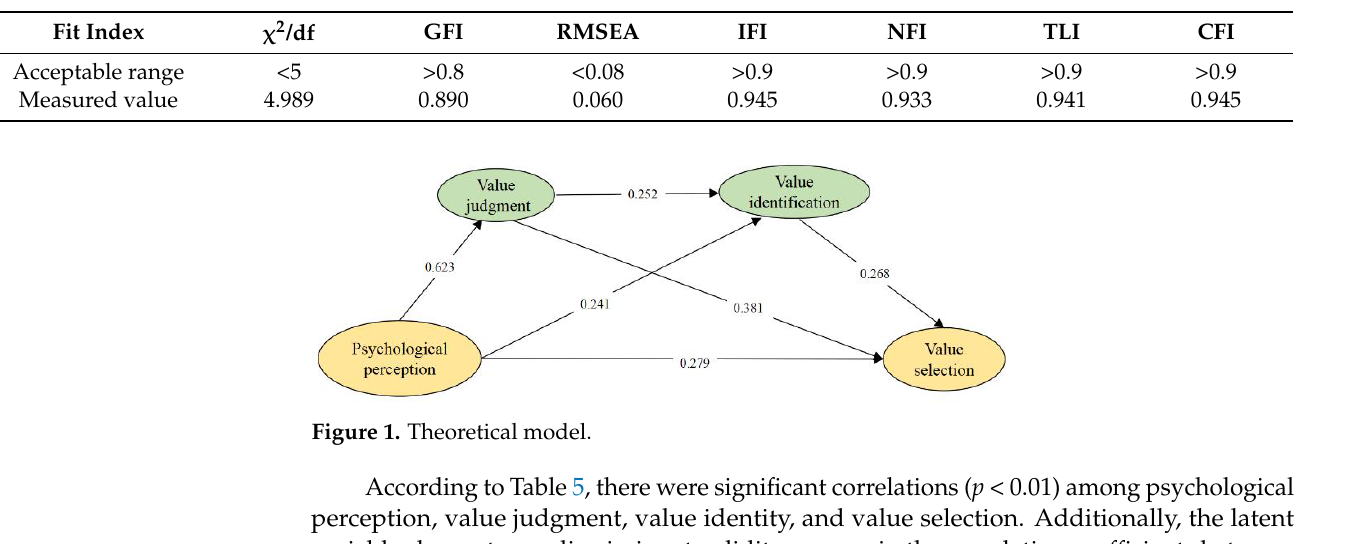
Table 4. Goodness of fit index of the structural model.